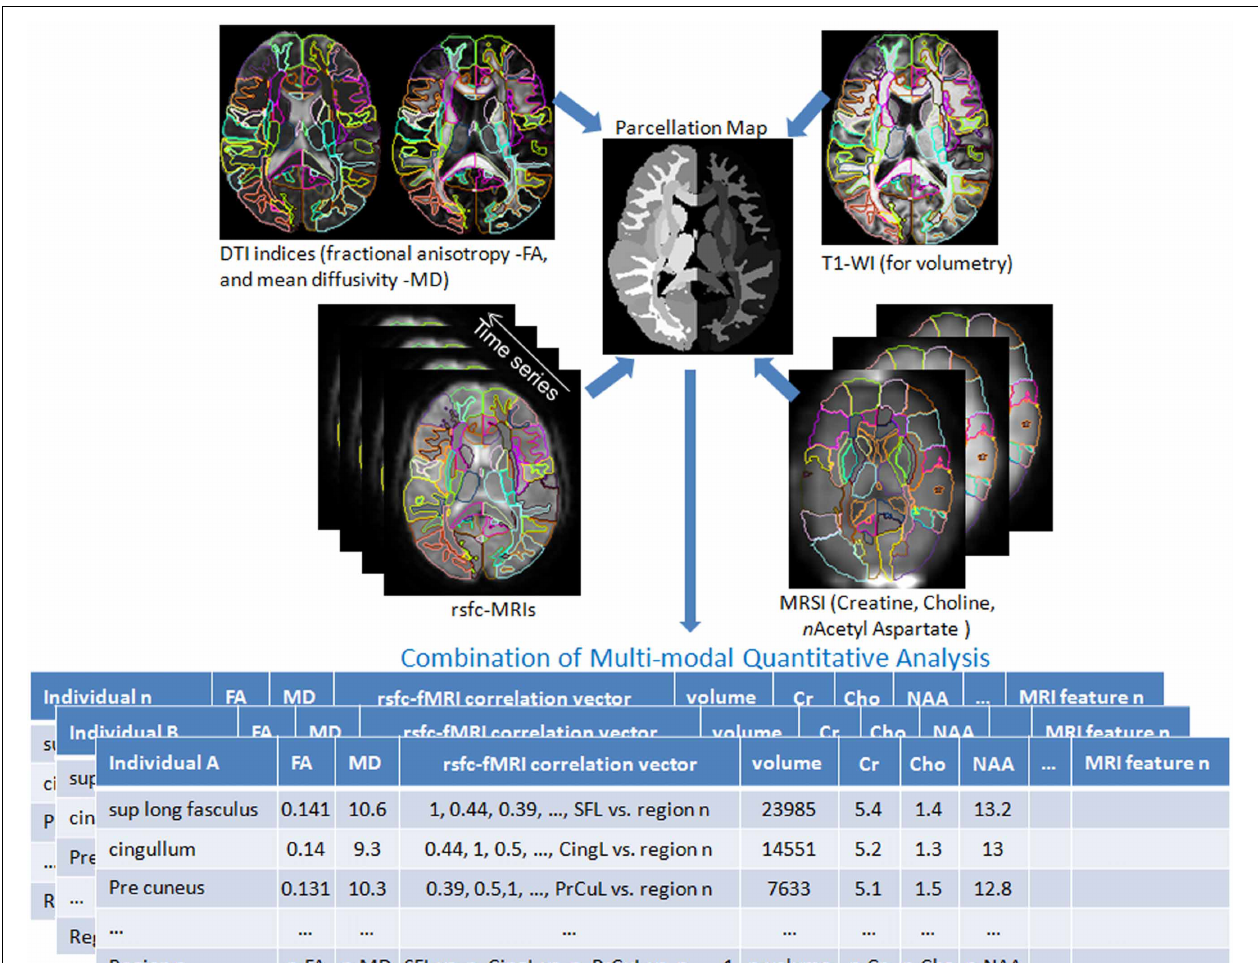
FIGURE 3 | Multiple image contrasts obtained from an individual using different MR pulse sequences. These multiple images are simultaneously parcellated into multiple structures, linking their coordinate systems (Parcellation Map). This procedure reduces the vast anatomical information into a parcellated series of approximately 200 structures and